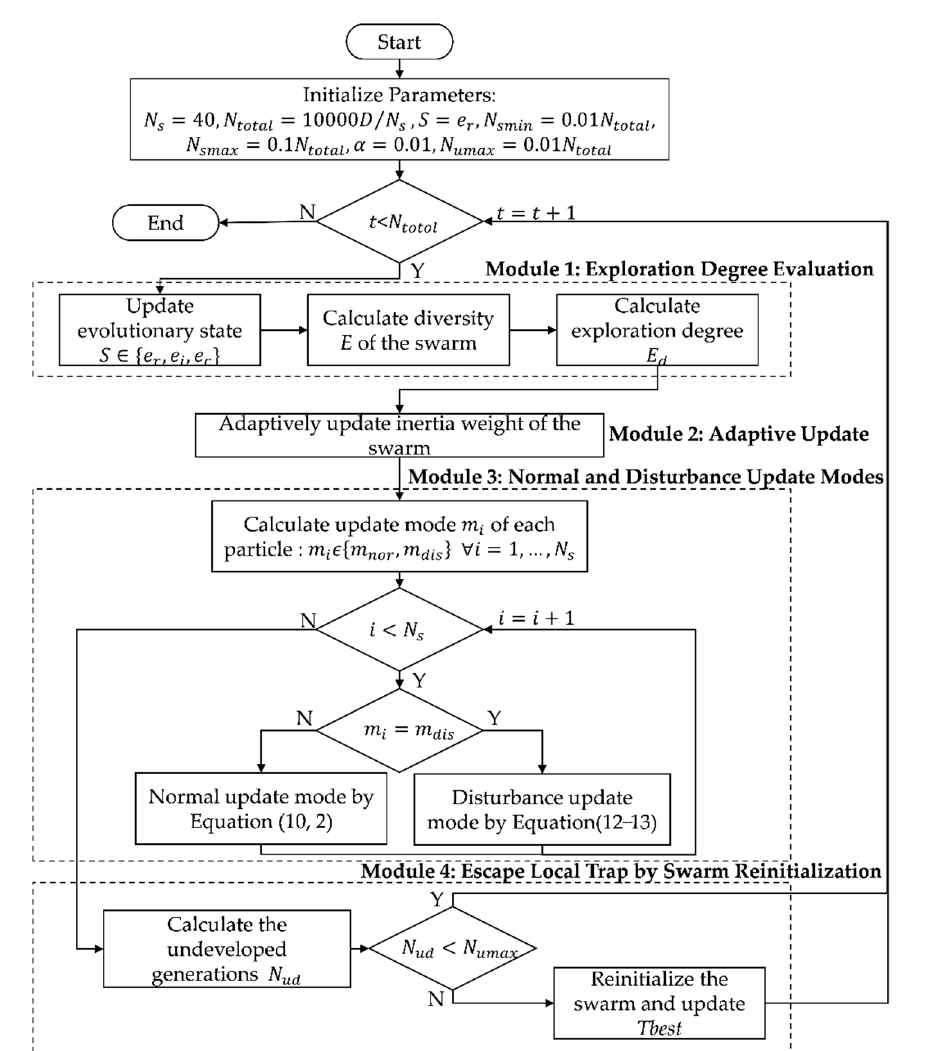
Figure 1. Flowchart of the particle swarm optimization variant based on a novel evaluation of diversity (PSO-ED).